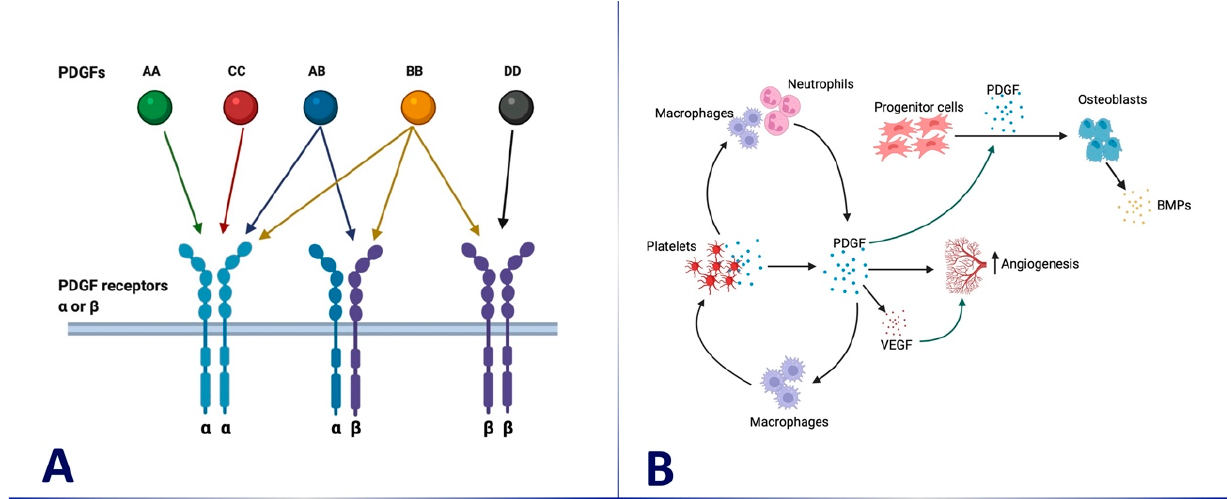
Figure 1. ( A ) PDGF 4 isoform homodimers and heterodimers binding on PDGF receptors for dimers on a cell surface ( α and/or β ). PDGF-AA, -BB, and -CC bind to PDGFR α / α , PDGF-AB, -BB, -CC, and -DD bind to PDGFR α / β , while PDGF-BB and DD bind to PDGFR β / β ; ( B ) At injury sites, platelets release α -granules containing PDGFs, which in turn induce chemotaxis and proliferation of a multitude of cells important in healing and bone regeneration. The activation of macrophages and neutrophils results in increased production of PDGF, which results in increased angiogenesis directly or as a result of increased vascular endothelial growth factor (VEGF). PDGF also induces differentiation of osteoblast progenitors to osteoblasts, resulting in increased production of bone morphogenetic proteins (BMPs) by osteoblasts.